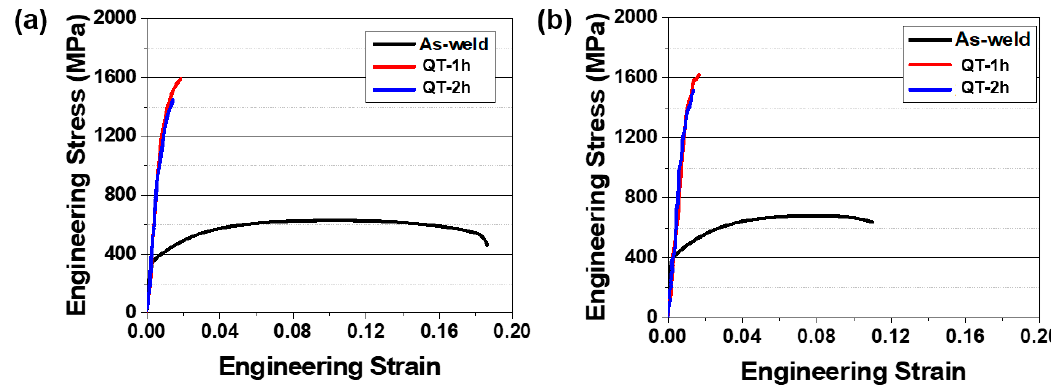
Figure 6. Engineering stress–strain curves determined from the uniaxial tensile test for the laser-arc hybrid weld joints: ( a ) Type-I and ( b ) Type-II.